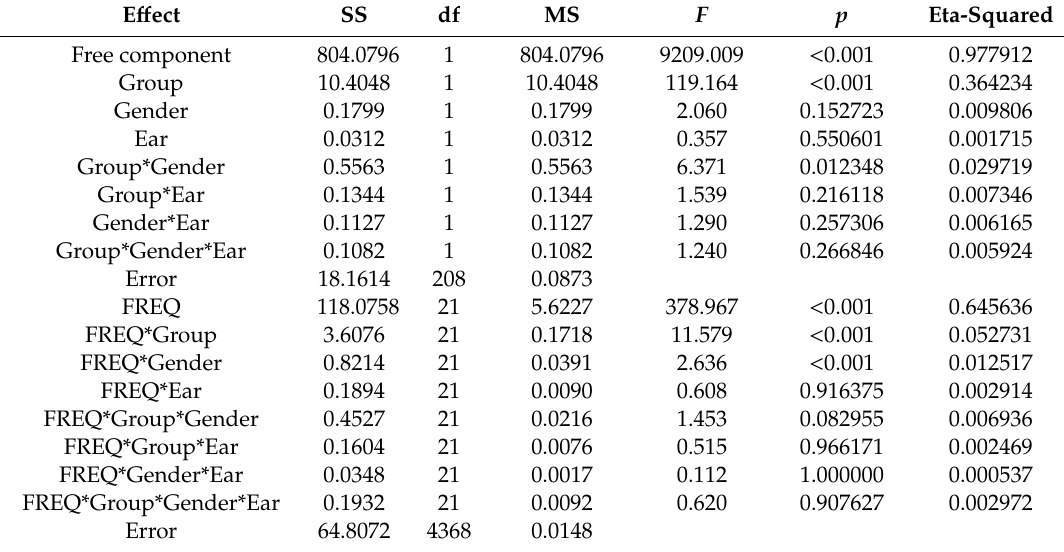
Table 2. Results of ANOVA. E ff ects of the independent variables Group, Ear, and Gender and dependent repeated-measure variable frequency (FREQ) on